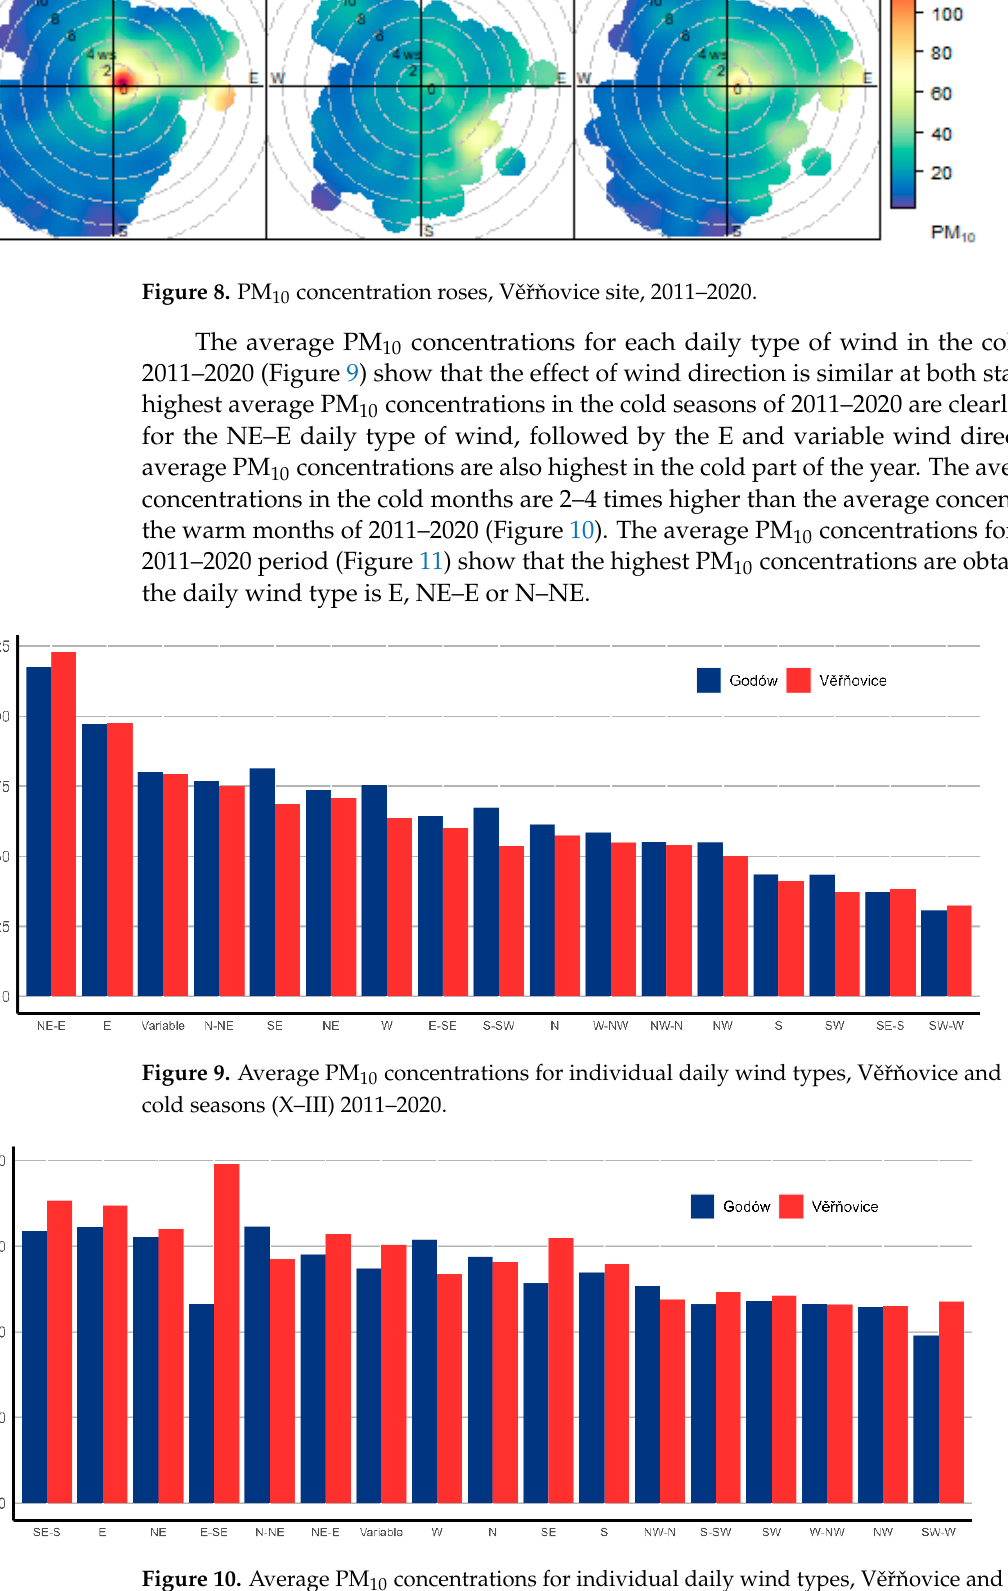
Figure 11. Average PM 10 concentrations for individual daily wind types, V ěřň ovice and Godów site, 2011–2020. The dependence of PM 10 concentrations on temperature is significant [38,39]. Figure 12 shows the PM 10 concentrations as a function of temperature and divided into individual daily types of wind. At low temperatures below 1 °C, the highest PM 10 concentrations